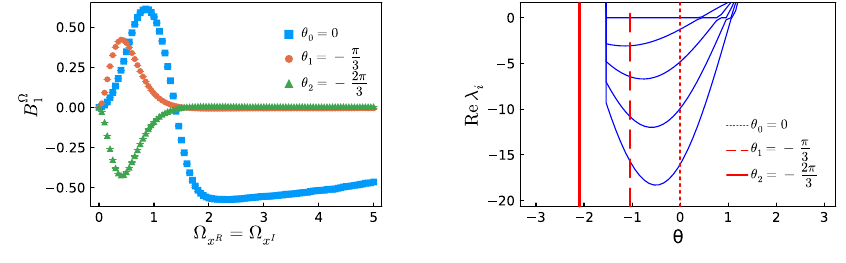
Figure 11 . (left) Boundary term according to the x 2 observable for the model of eq. (B.1) with σ = 4 i and λ = 2 , evaluated for the three different kernels K i discussed in the main text. (right) the five eigenvalues of the Fokker-Planck operator with the largest real part (blue lines) plotted against the kernel parameter θ . The position of the two kernels that optimize L